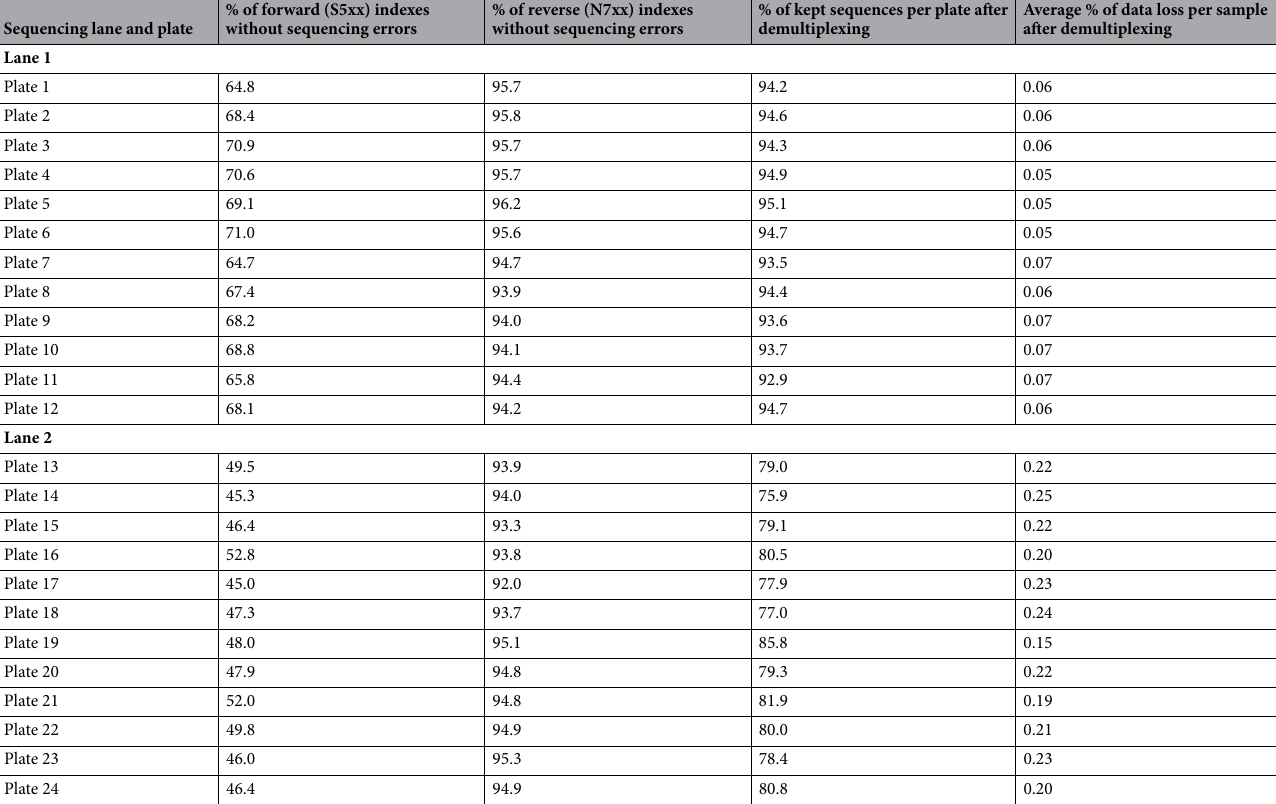
Table 1. Comparison between indexes of raw data sequences and merged, demultiplexed sequences for each plate. The number of reads is given in percent (%), with a specification of: (i) how many reads are present without any sequencing errors in the indexes (column 1 + 2), (ii) how many reads can still be assigned to samples when running the demultiplexing (bash) script (column 3) and (iii) how many reads per sample were lost on average due to the demultiplexing script used (column 4).